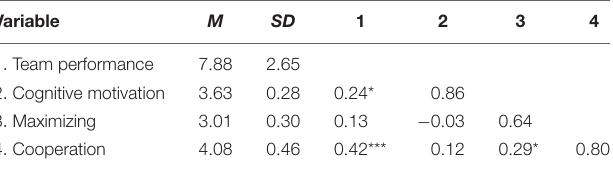
TABLE 1 | Descriptive statistics, correlations, and coefficient